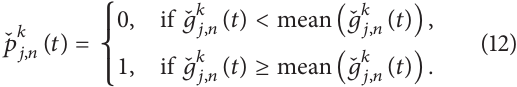
as blobs [35, p. 248]. As a result, each blob is associated with a single note, giving the onset and offset times for the note and its frequency contour. This representation further increases the sparsity of the gains 𝑔 𝑗,𝑛 (𝑡) , yielding less interference and better